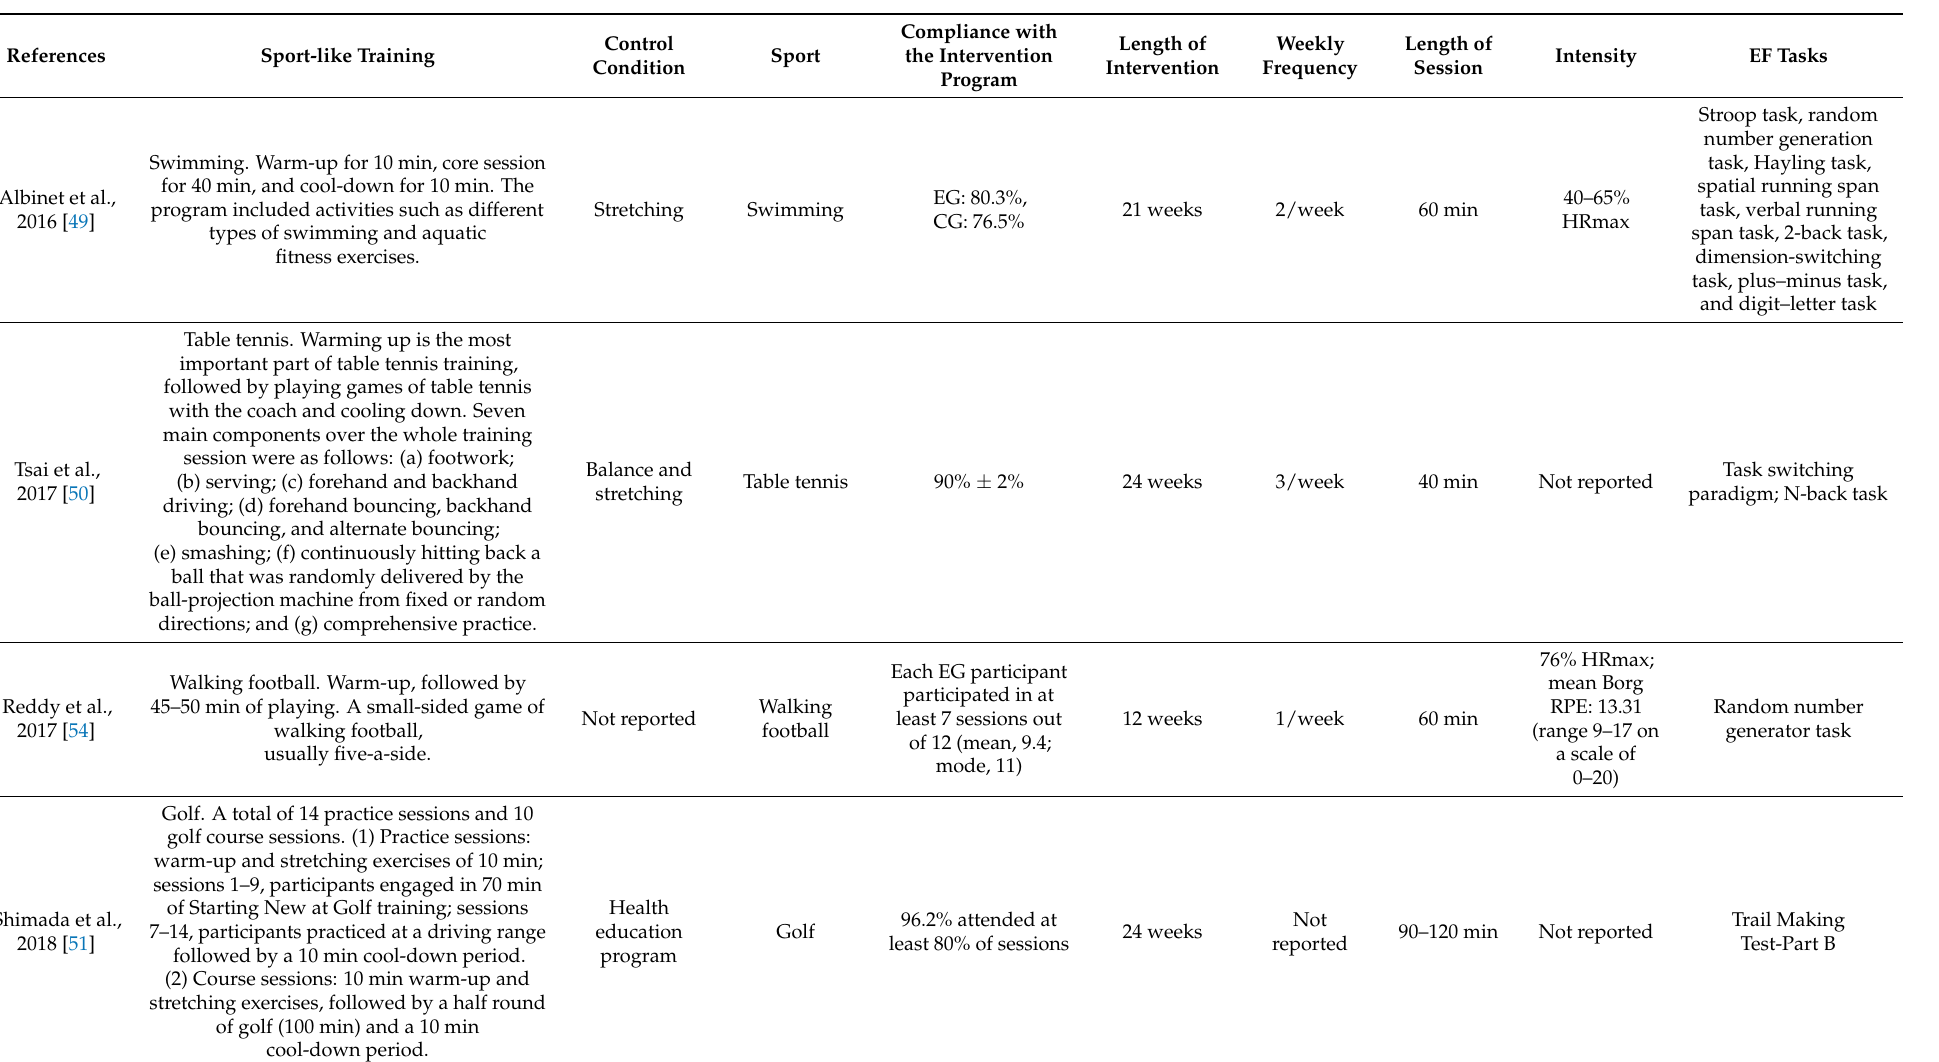
Table 3. Intervention characteristics of the included